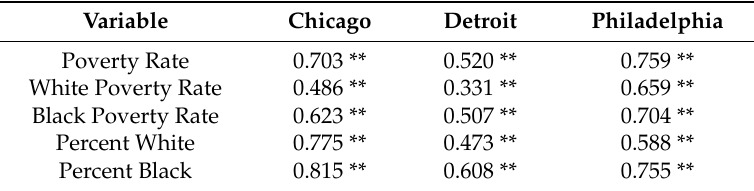
Table 4. Moran’s I for Shrinking Cities in 2010.